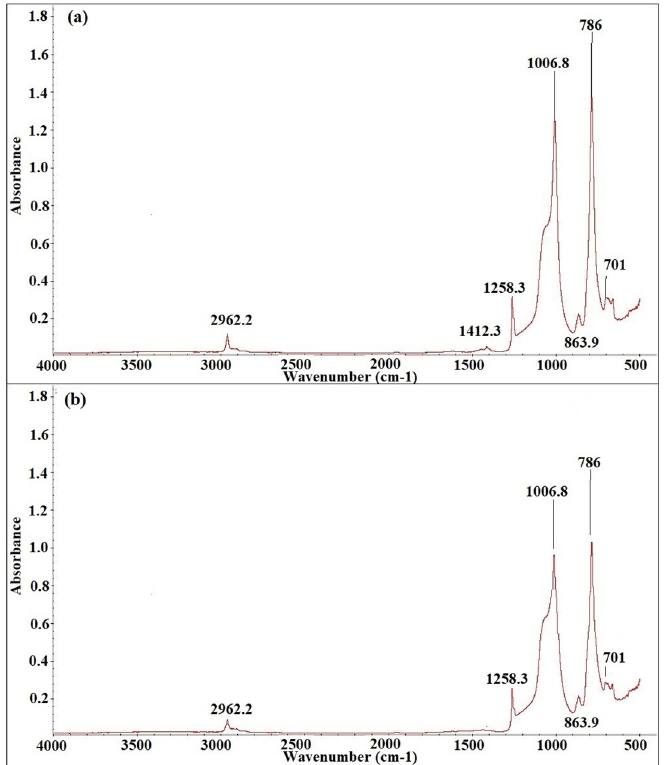
Fig 16. Spectrograph for S0 a) Before aging, b) After